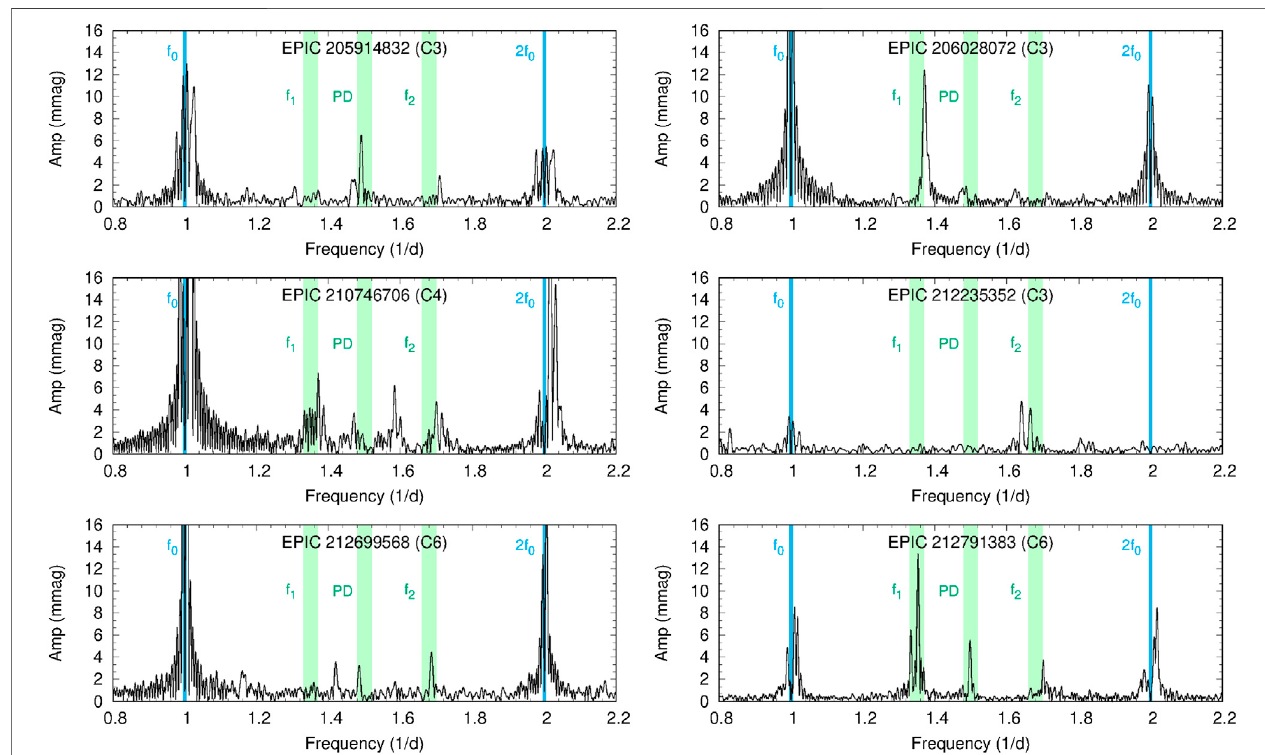
FIGURE 6 | Examples of residual Fourier spectra of K2 RR Lyrae stars showing low-amplitude additional peaks (after removing the frequency series of the main pulsation). Green areas are the expected frequency regions of the fi rst radial overtone, period doubling (PD), and the second radial overtone, respectively. Based on the light curves published by Plachy et al.